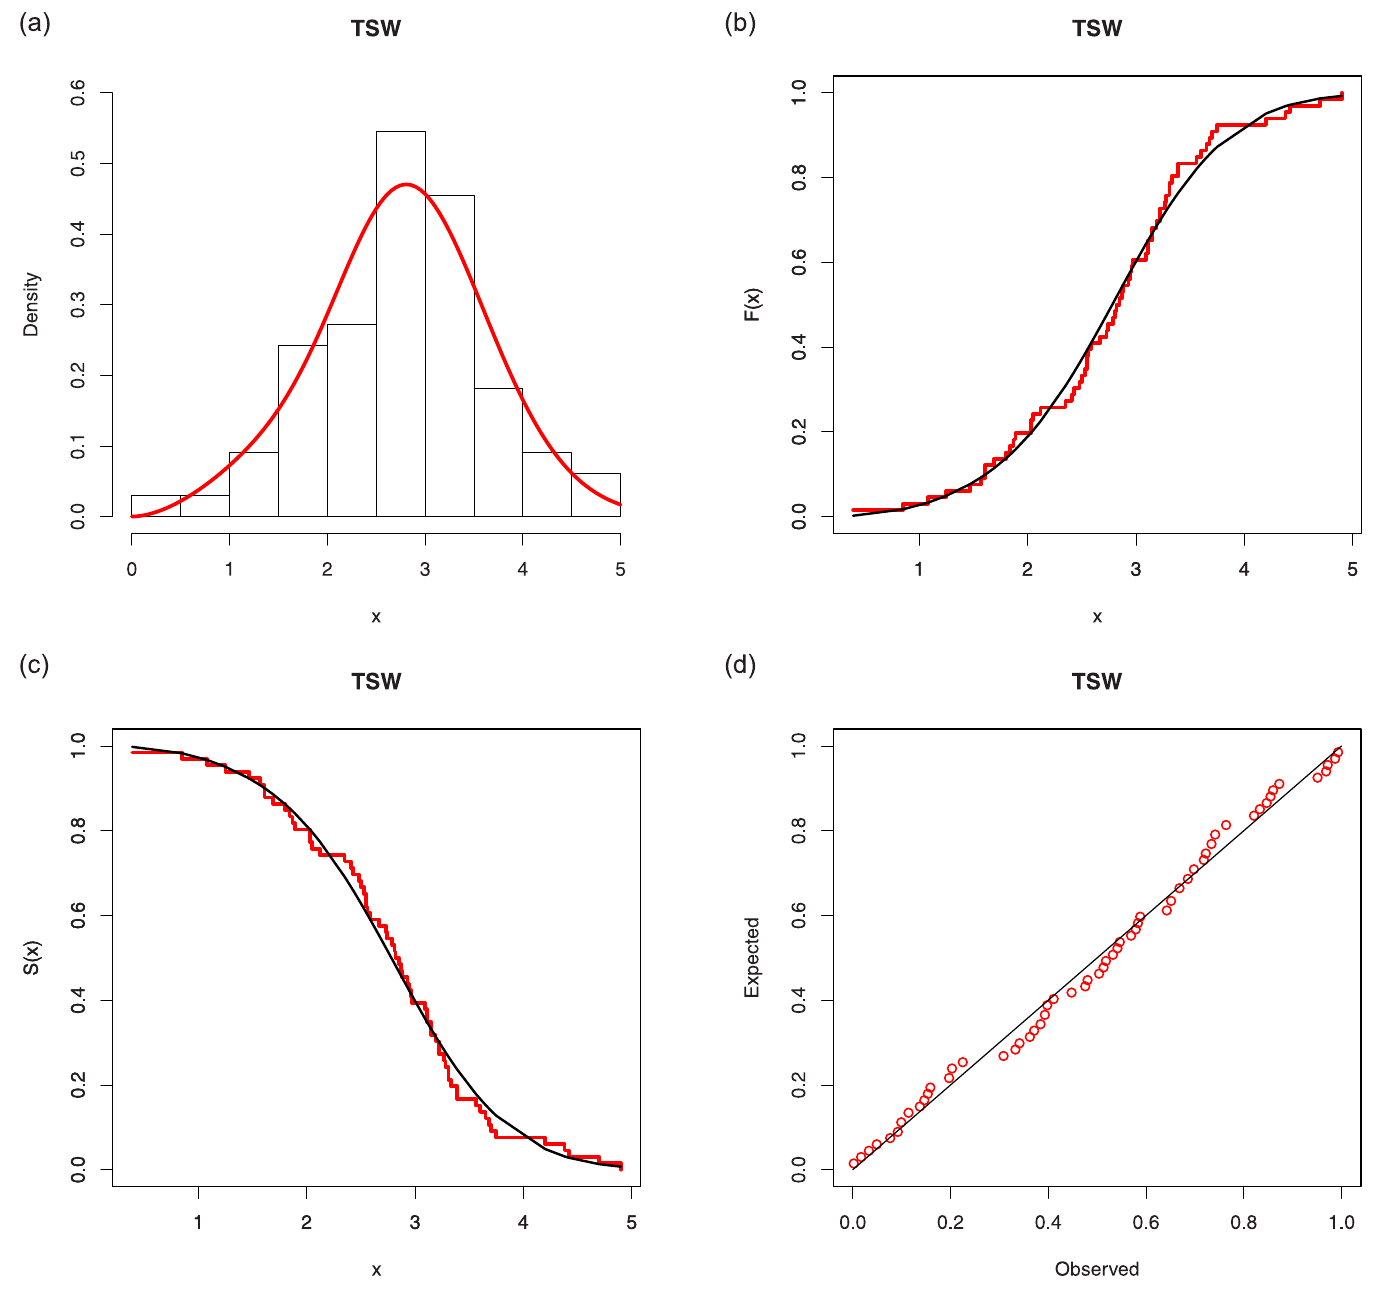
Fig 7. Several fits for the TSW model for the second data set: (a) estimated pdf over the histogram, (b) estimated cdf over the empirical cdf, (c) estimated sf over the empirical sf and (d) P-P plot.